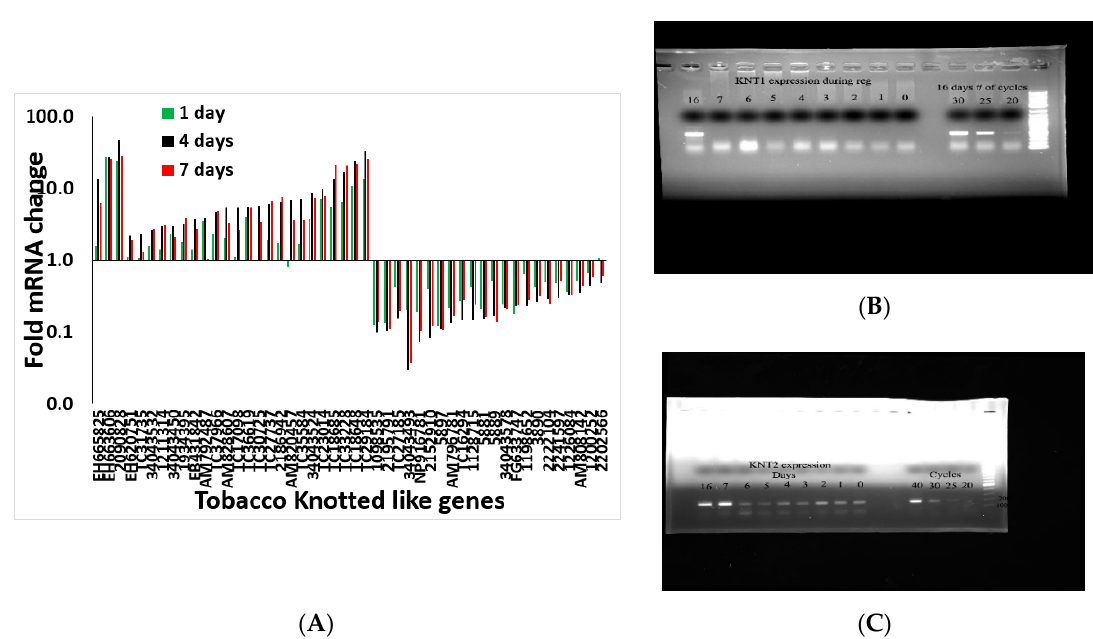
Figure 8. ( A ): Transcript pattern of Knotted gene family members during the induction period of shoot regeneration. The gene numbers are depicted on the x-axis. ( B ): expression of NtKnotted1 during the induction period. ( C ): expression of NtKnotted2 during the induction period.